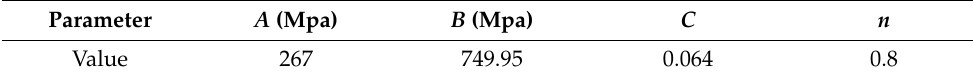
Table 4. Parameters used in the JC plasticity model (obtained with tensile tests).